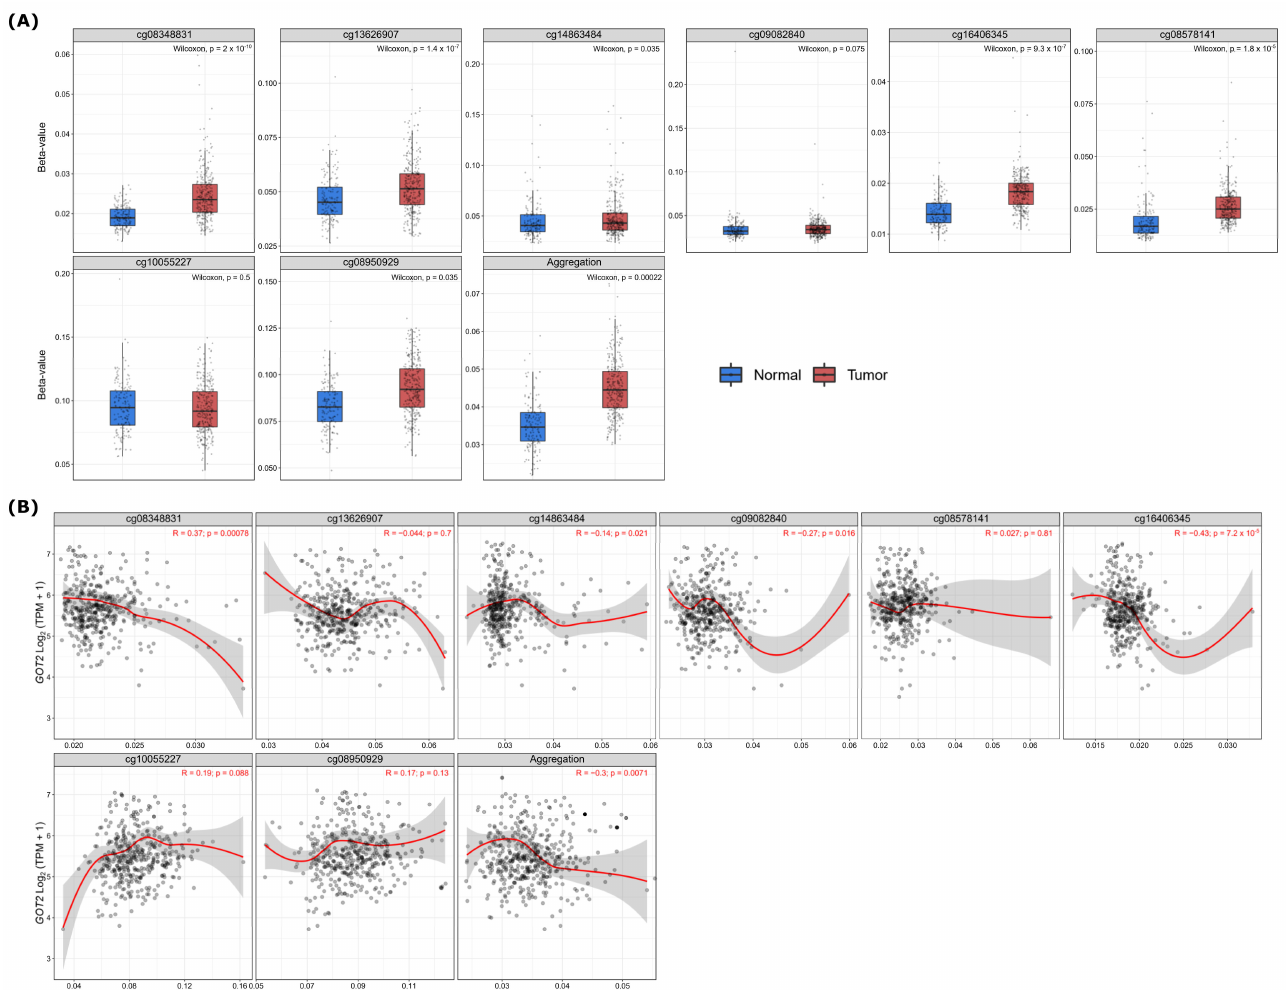
Figure 7. Hypermethylation of GOT2 leads to downregulated expression in KIRC. ( A ) Differen- tial methylation level of eighth GOT2 probes (cg08348831, cg13626907, cg14863484, cg09082840, cg16406345, cg08578141, cg10055227 and cg08950929) between KIRC patients ( n = 313) and normal samples ( n = 157) from TCGA. ( B ) Spearman’s correlation between methylation level ( β -values, 450 k array) and mRNA level (Log2-scaled, TPM + 1) of GOT2 in KIRC samples from